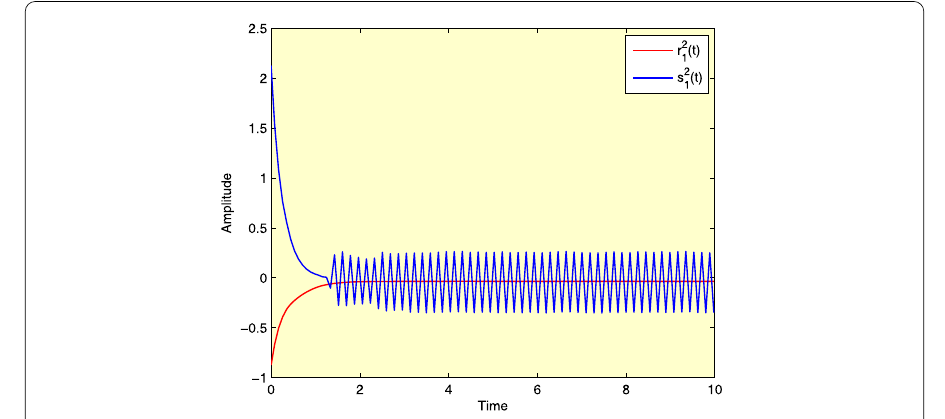
Figure 7 Time responses of state variables r 2 1 ( t ), s 2 1 ( t ) of NN models (1) and (3)